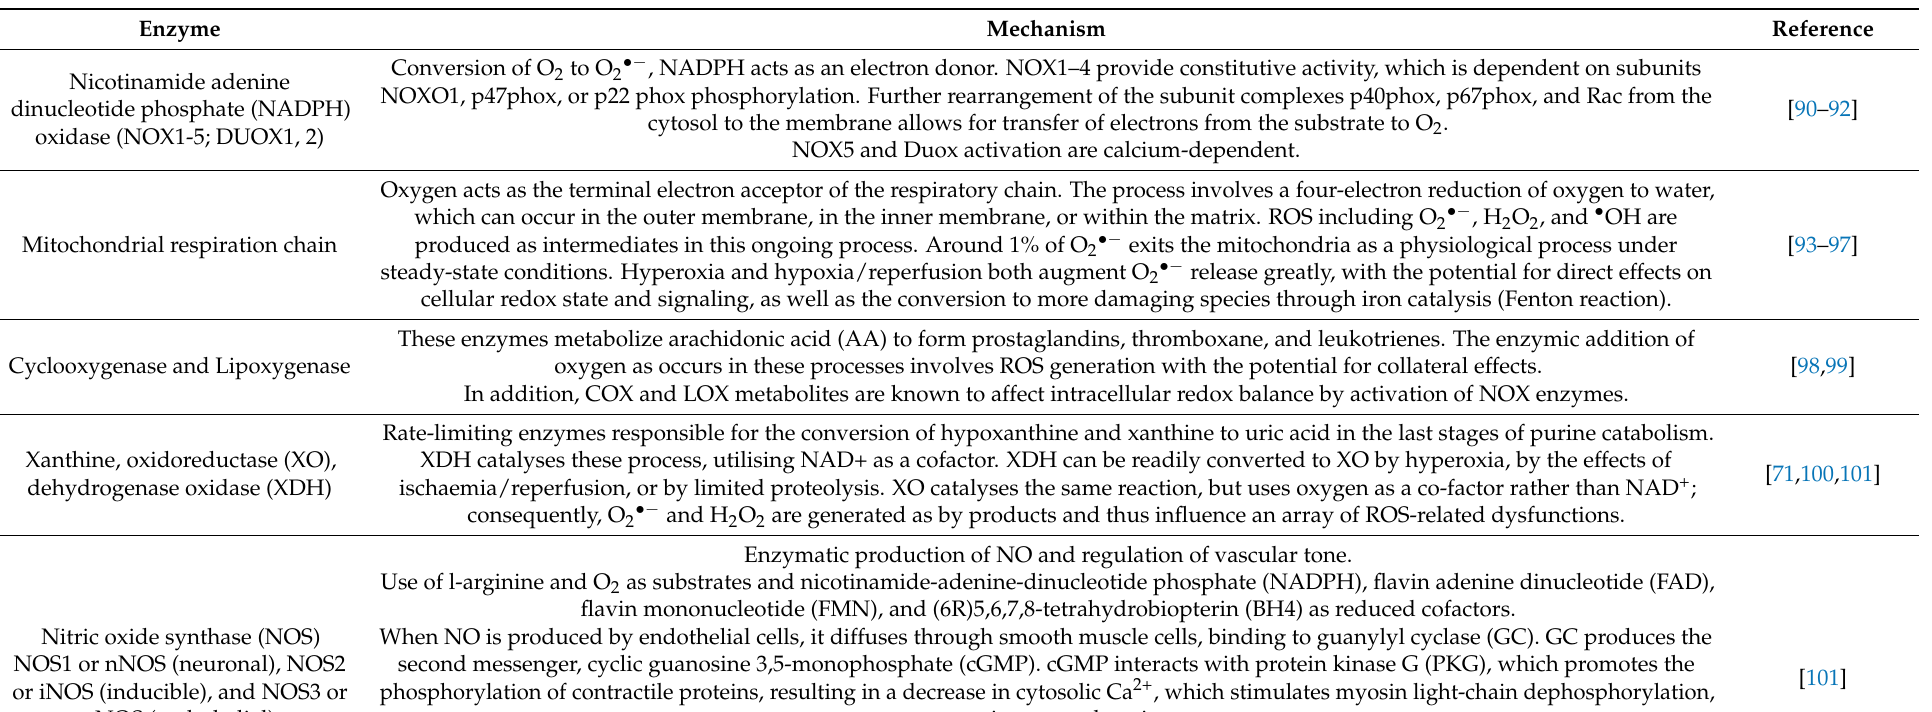
Table 1. Main reactive oxygen and nitric species